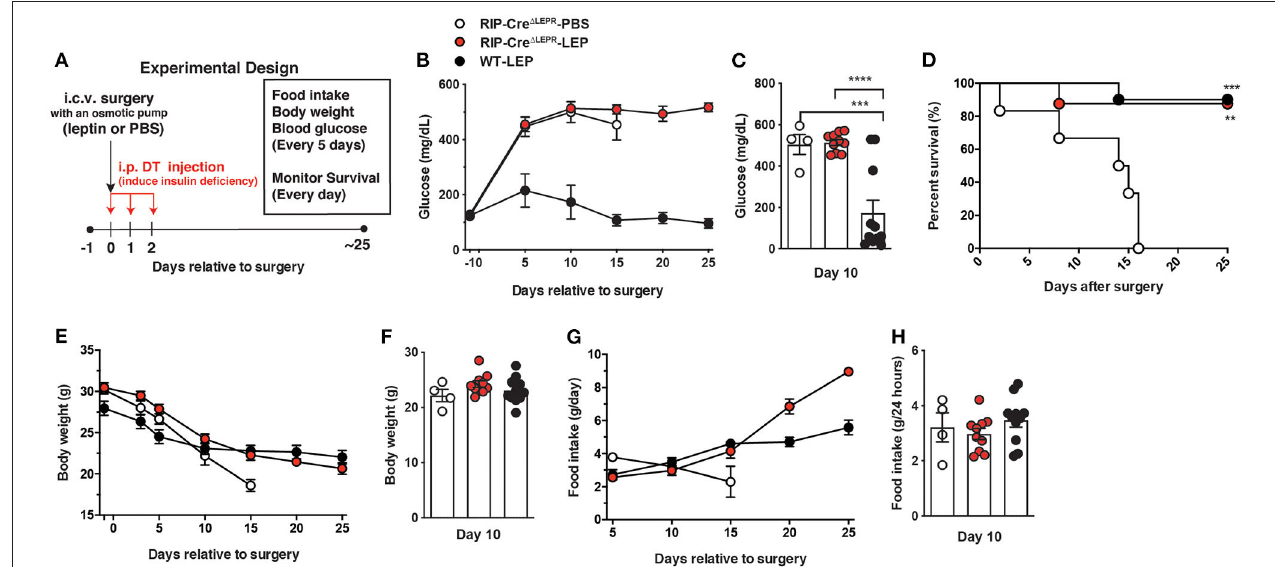
FIGURE 2 | Deletion of LEPRs in RIP-Cre 25Mgn neurons blocks glucose-lowering effects of leptin in insulin-deficient mice. (A) Experimental design for i.c.v. leptin injection into insulin-deficient mice. (B) The time course of blood glucose ( n = 5; RIP-Cre 1 LEPR -PBS, 11; RIP-Cre 1 LEPR -LEP, and 11; WT-LEP at day − 1), (C) blood glucose at Days 10 ( n = 4; RIP-Cre 1 LEPR -PBS, 10; RIP-Cre 1 LEPR -LEP, and 11; WT-LEP at day − 1), (D) the time course of survival percentage ( n = 5; RIP-Cre 1 LEPR -PBS, 11; RIP-Cre 1 LEPR -LEP, and 11; WT-LEP at day 0), (E) the time course of body weight ( n = 4; RIP-Cre 1 LEPR -PBS, 11; RIP-Cre 1 LEPR -LEP, and 11; WT-LEP at day − 1), (F) body weight at Days 10 ( n = 4; RIP-Cre 1 LEPR -PBS, 10; RIP-Cre 1 LEPR -LEP, and 11; WT-LEP at day − 1), (G) the time course of food intake 10 ( n = 4; RIP-Cre 1 LEPR -PBS, 10; RIP-Cre 1 LEPR -LEP, and 11; WT-LEP at day 5), and (H) food intake at Days 10 ( n = 4; RIP-Cre 1 LEPR -PBS, 10; RIP-Cre 1 LEPR -LEP, and 11; WT-LEP at day − 1) in insulin-deficient RIP-Cre 1 LEPR mice chronically administered leptin into the lateral ventricle (25 ng/0.11 µ L/h). Insulin deficiency was induced by administration of DT. Control group for leptin administration was administered sterile vehicle (PBS). Genetic control group (WT) were homozygous Lepr flox without RIP-Cre 25Mgn transgene. Values are mean ± S.E.M. **** p < 0.0001, *** p < 0.001, ** p < 0.01. One way ANOVA followed by Tukey’s multiple comparison test (C,F,H) and Log-rank (Mantel-Cox) testing (D) was used to analyze the